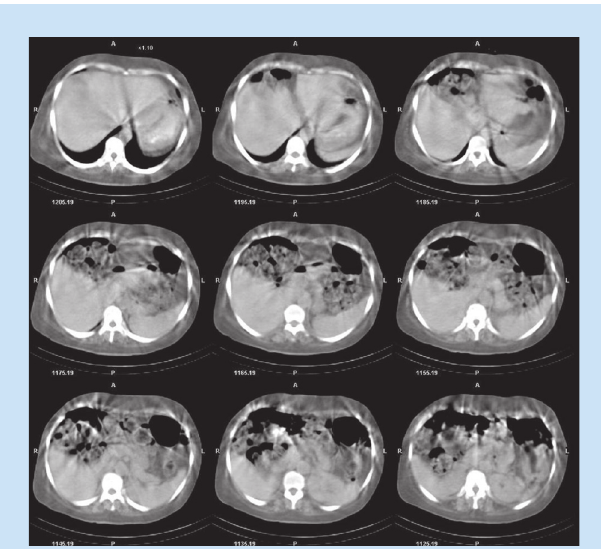
Fig. 2. The CT scans for localisation on the same imaging machine (hybrid equipment) show air in the area of no gallium uptake, suggest- ing the clinical diagnosis of Chilaiditi’s syndrome.